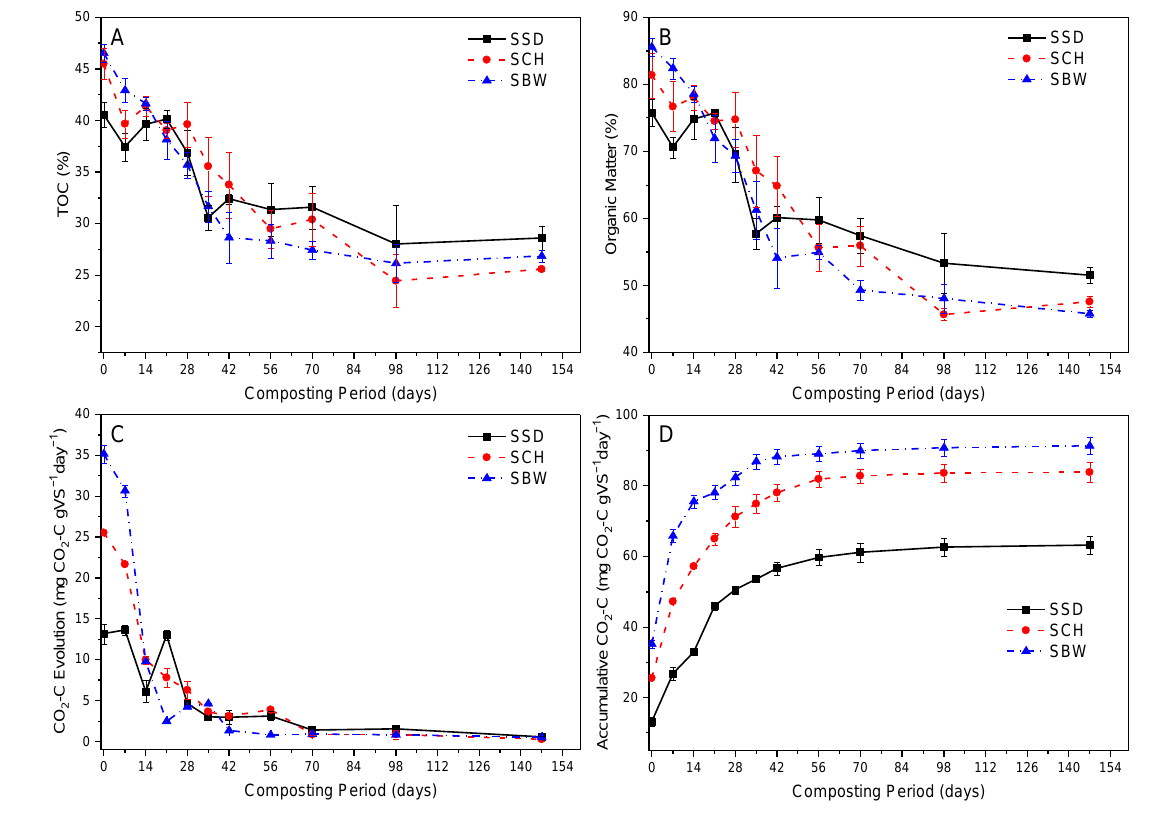
Figure 3. Changes in: ( A ) total organic carbon; ( B ) organic matte; ( C ) carbon dioxide rate per organic matter (CO 2 -C/TVS); and ( D ) cumulative carbon dioxide per organic matter during the composting of faecal sludge-FS with brewery waste-SBW, coffee husks-SCH, and sawdust-SSD. Error bars represent the standard error of n = 2.